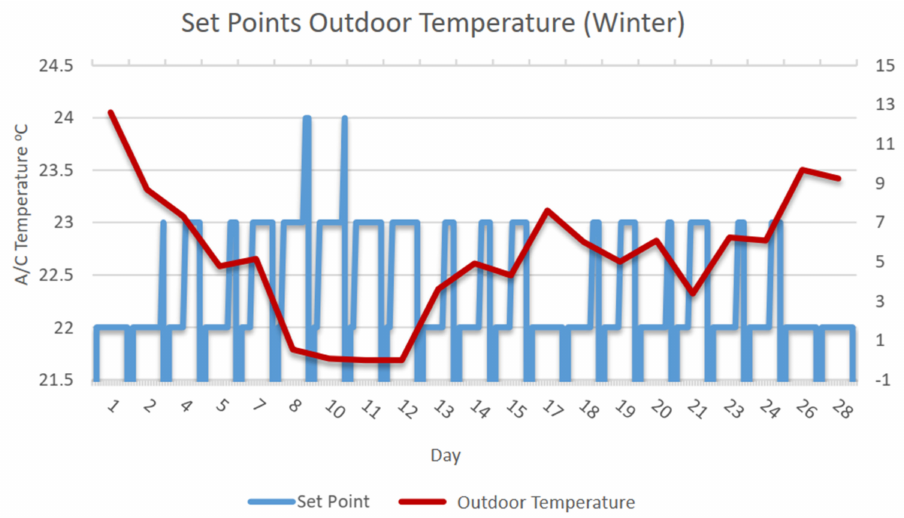
Figure 13. Set points and outdoor temperatures (winter).